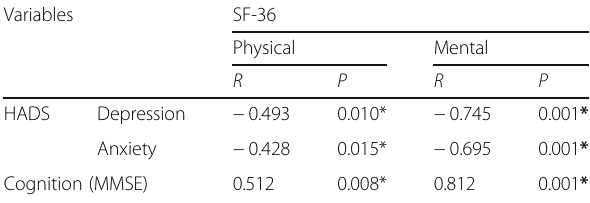
Table 4 The impact of psychiatric disturbances on HRQOL in the study